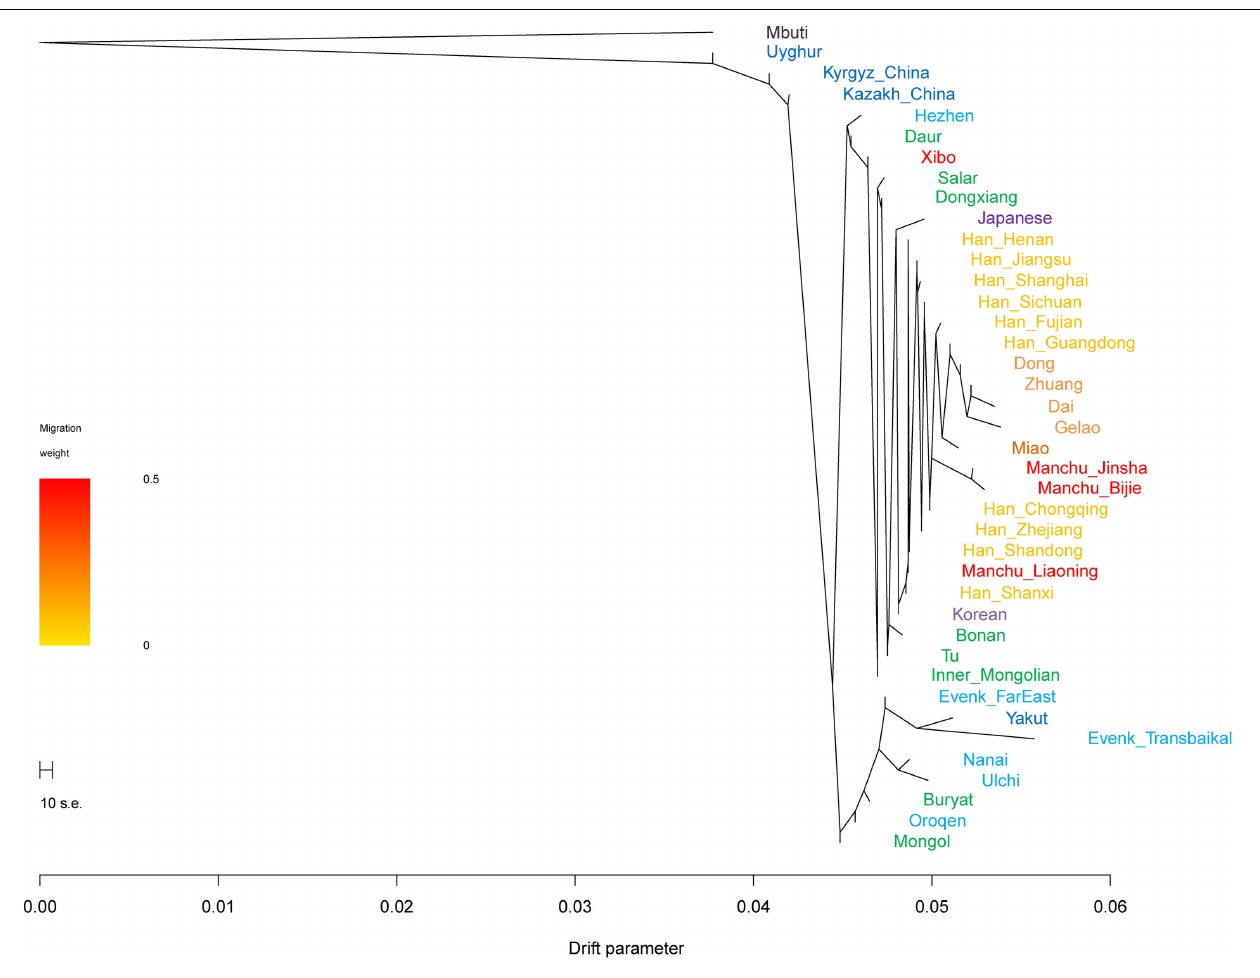
FIGURE 6 | Phylogenetic relationships among Turkic, Tungusic, Mongolic, Tai-Kadai, and Hmong-Mien speakers. Mbuti population from central Africa was set as the root. Different populations were marked according to their linguistic affinity.